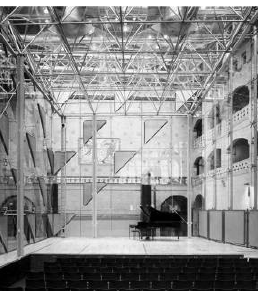
Figure 7: Glass music hall, Amsterdam. Figure 8: Interior view.